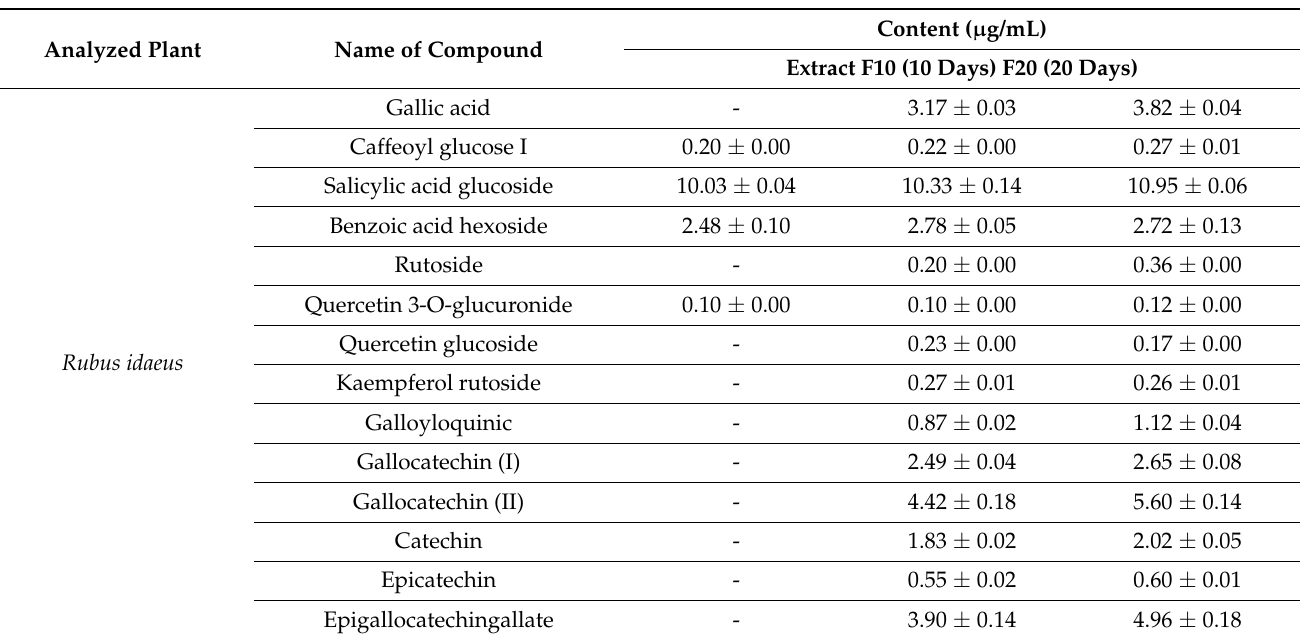
Table 2. UHPLC/DAD/ESI-MS quantitative analysis of R. rubrum , R. ideaus, and F. vesca